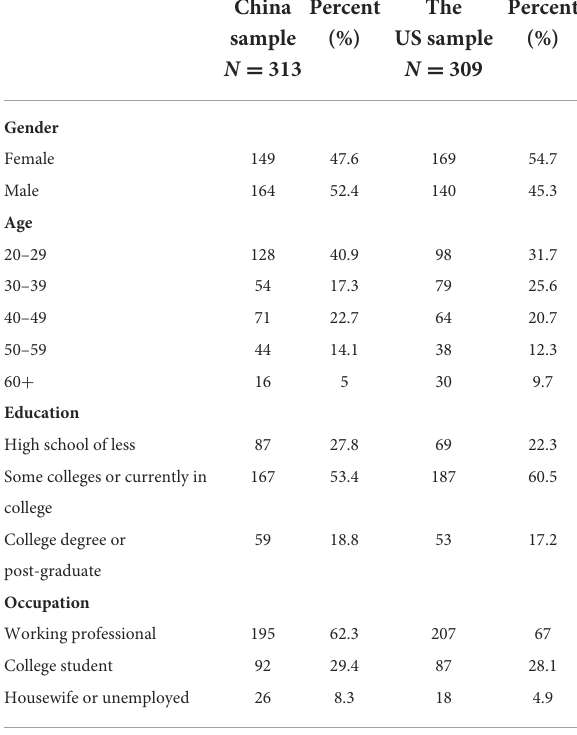
TABLE 1 China sample and the US